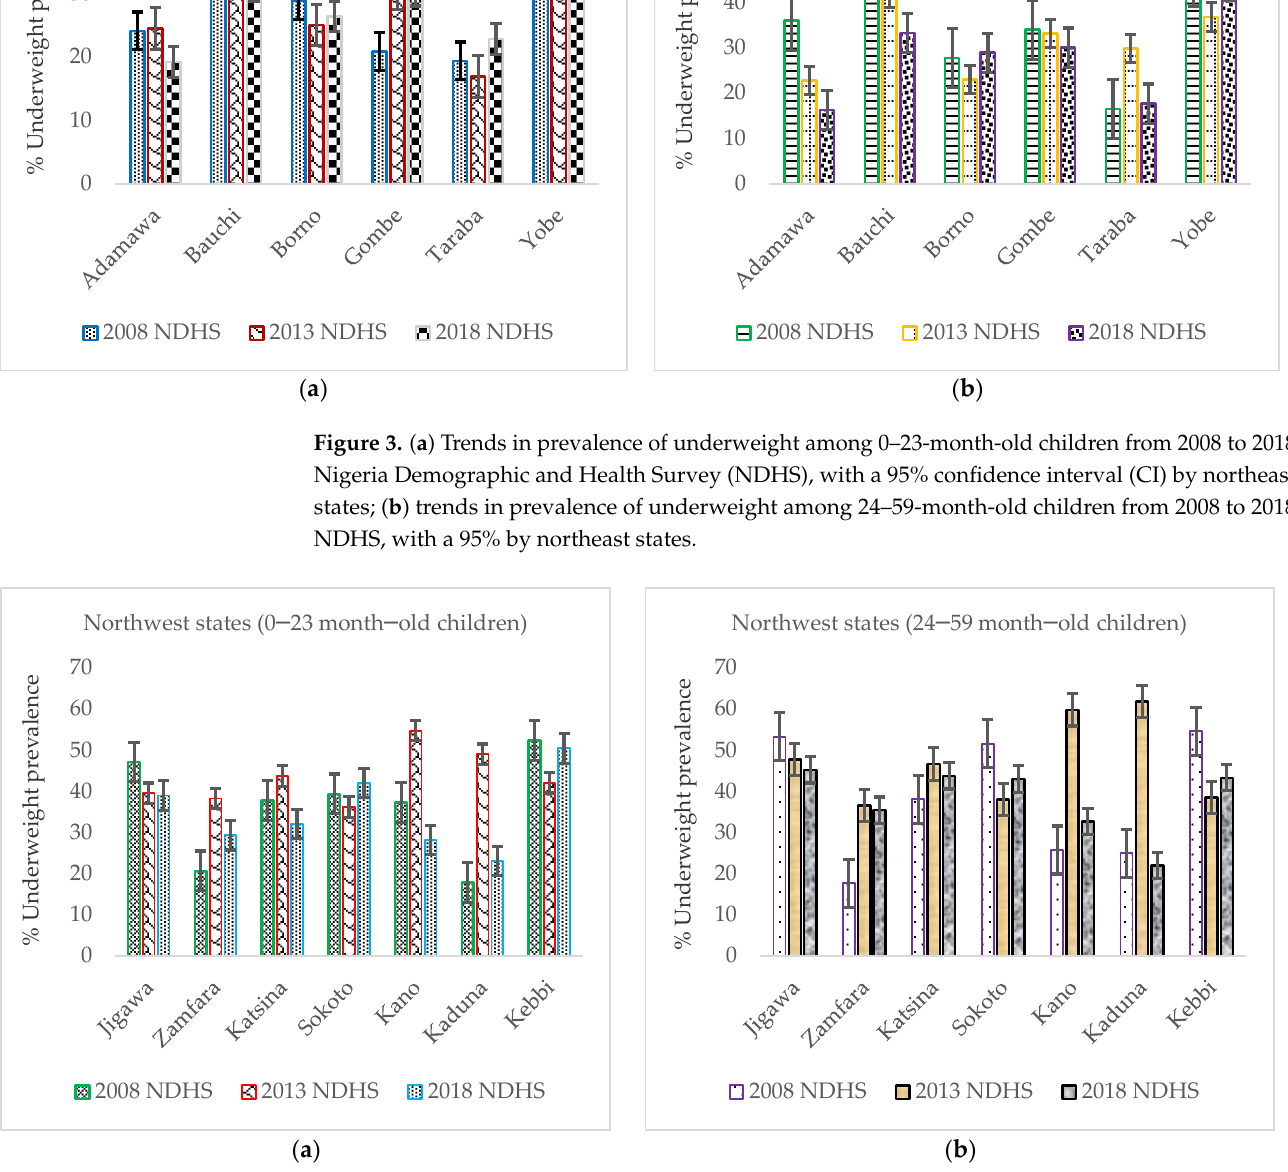
Figure 4. ( a ) Trends in prevalence of underweight among 0–23-month-old children from 2008 to 2018 Nigeria Demographic and Health Survey (NDHS), with a 95% confidence interval by northwest states; ( b ) trends in prevalence of underweight among 24–59-month-old children from 2008 to 2018 NDHS, with a 95% CI by northwest states.